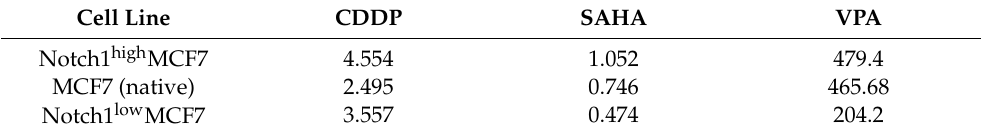
Table 1. IC 50 values ( µ g/mL) for cisplatin (CDDP) and two histone deacetylase inhibitors